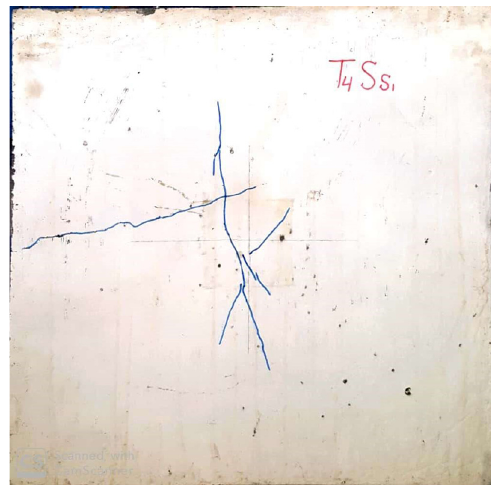
Figure 13: Crack pattern under impact - fl exural loads of the T4SS1 slab top